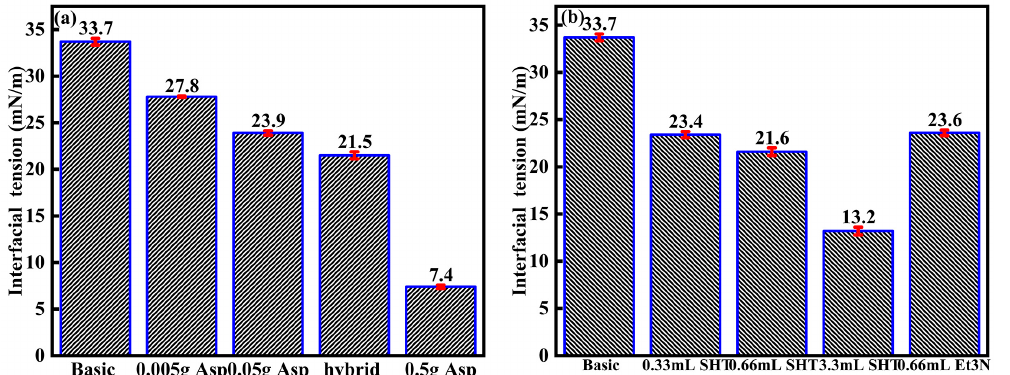
Figure 8. The oil–water interfacial tension as a function of asphaltenes content, SHT content, and Et 3 N content at ambient conditions (“hybrid” means 0.33 mL SHT and 0.05 g asphaltenes).